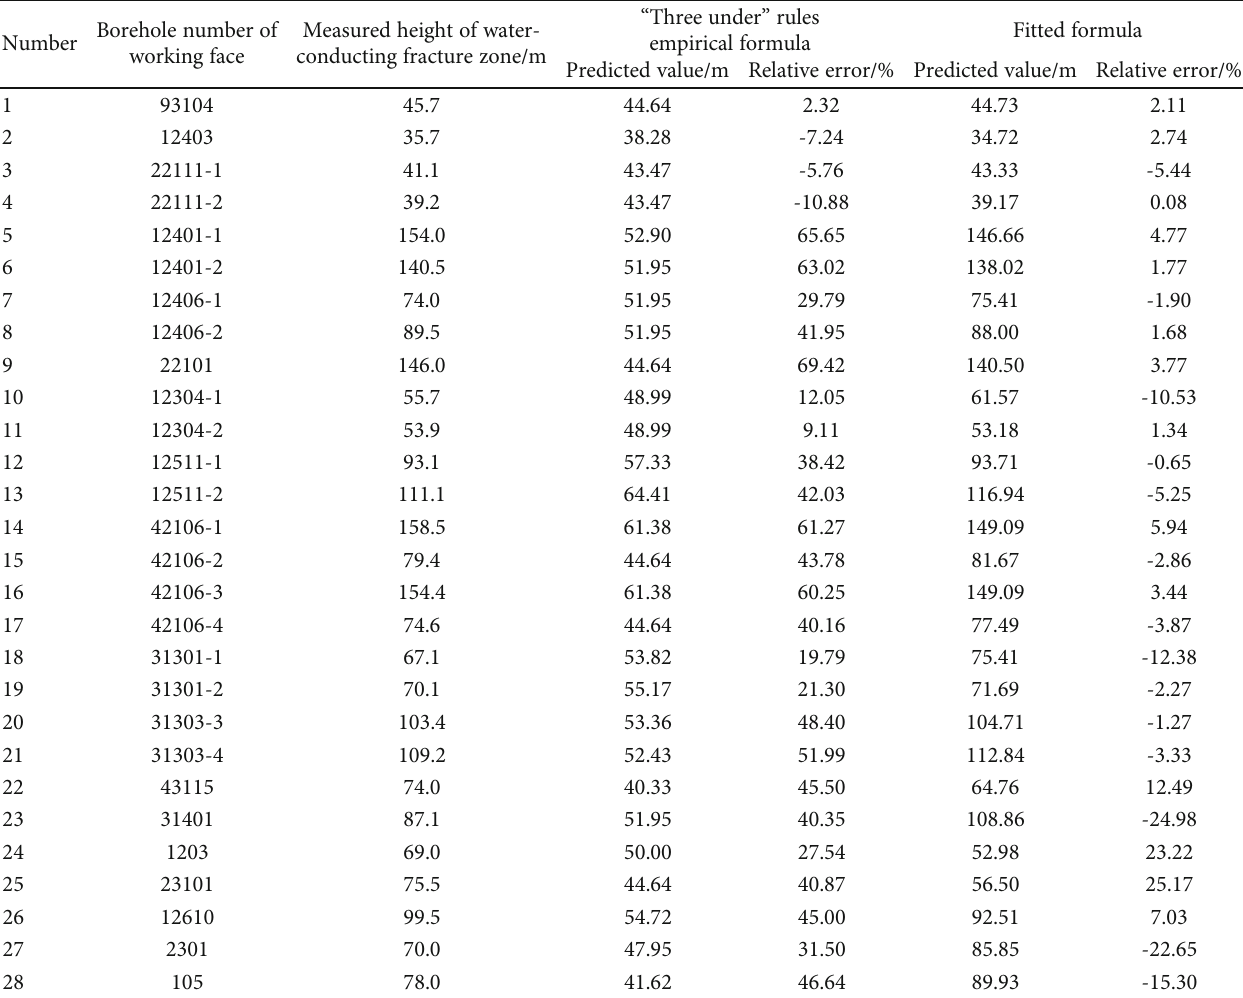
Table 3: Relative error